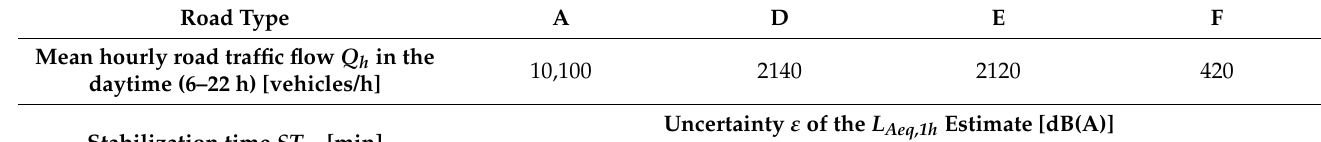
Table 5. Cumulative probability [%] of the L Aeq,1h estimate computed by Equation (5) for each road type and uncertainty ε for some ST 75 values and daytime mean hourly road traffic flow Q h .